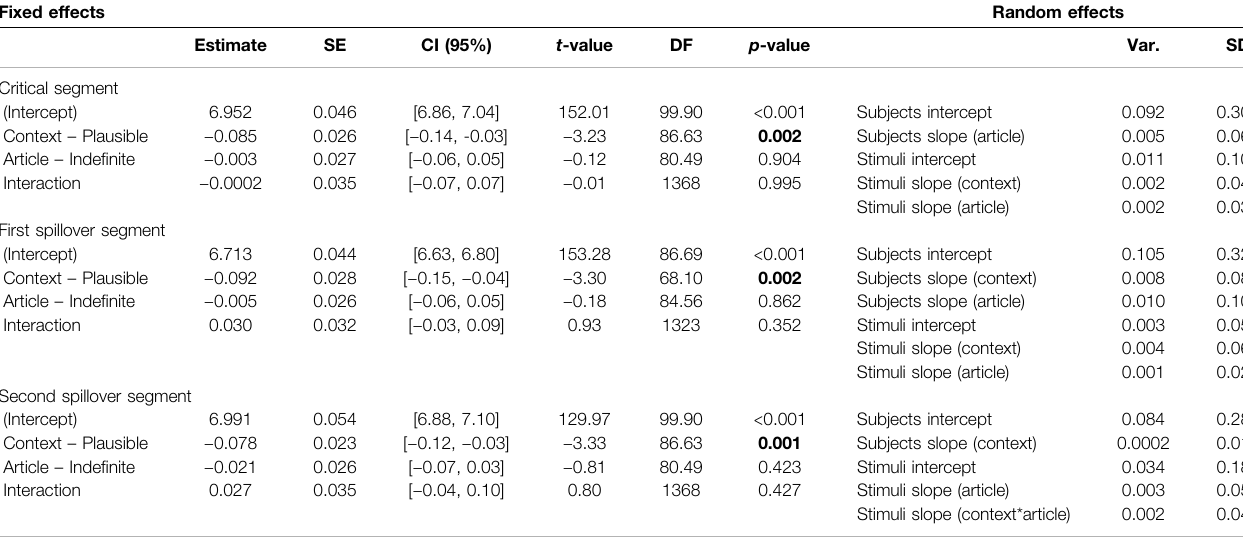
TABLE 2 | Statistical results of the selected parsimonious models for Experiment